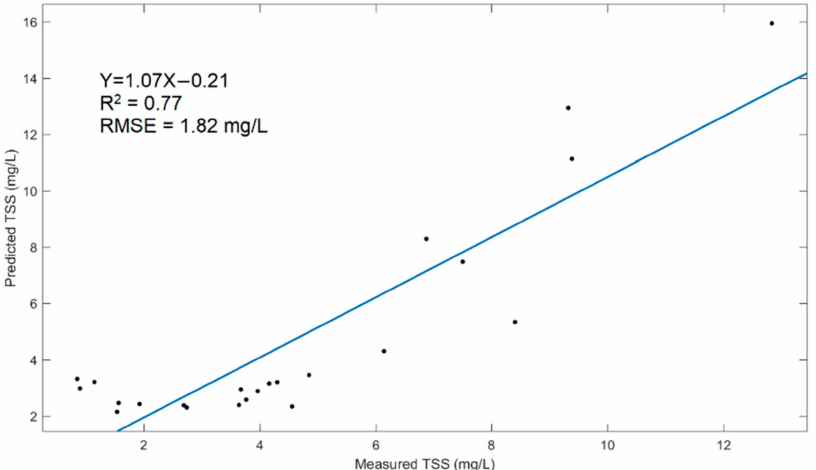
Figure 2. Relationship between the measured and predicted TSS.